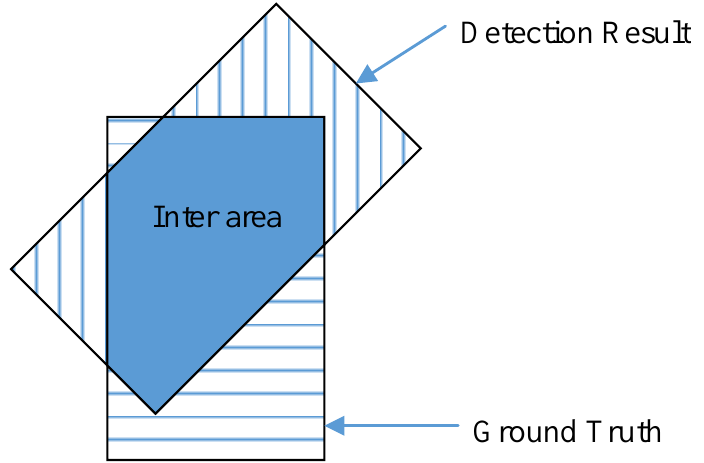
Figure 10. Area definition in the IOU calculation.